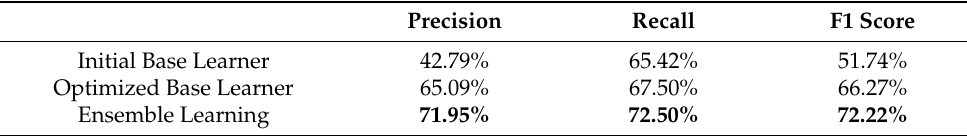
Table 2. Network training evaluation